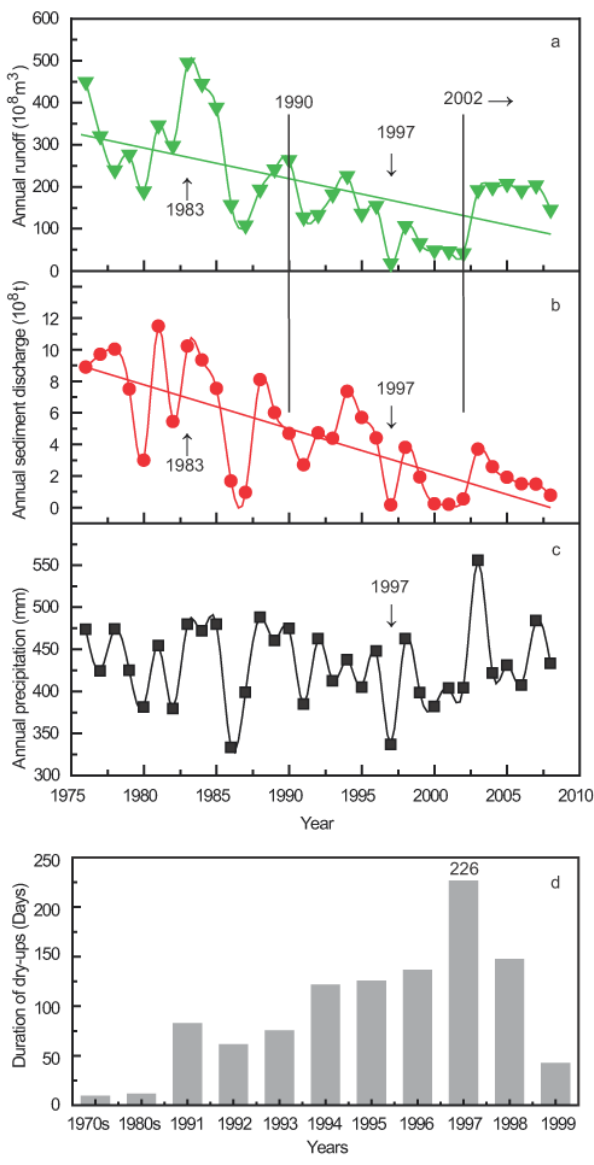
Fig. 2. Annual runoff (a) and sediment (b) at Lijin Hydrological Station, the annual precipitation (c) of the Yellow River Basin and seasonal drying ups (d) of Yellow River from 1976 to